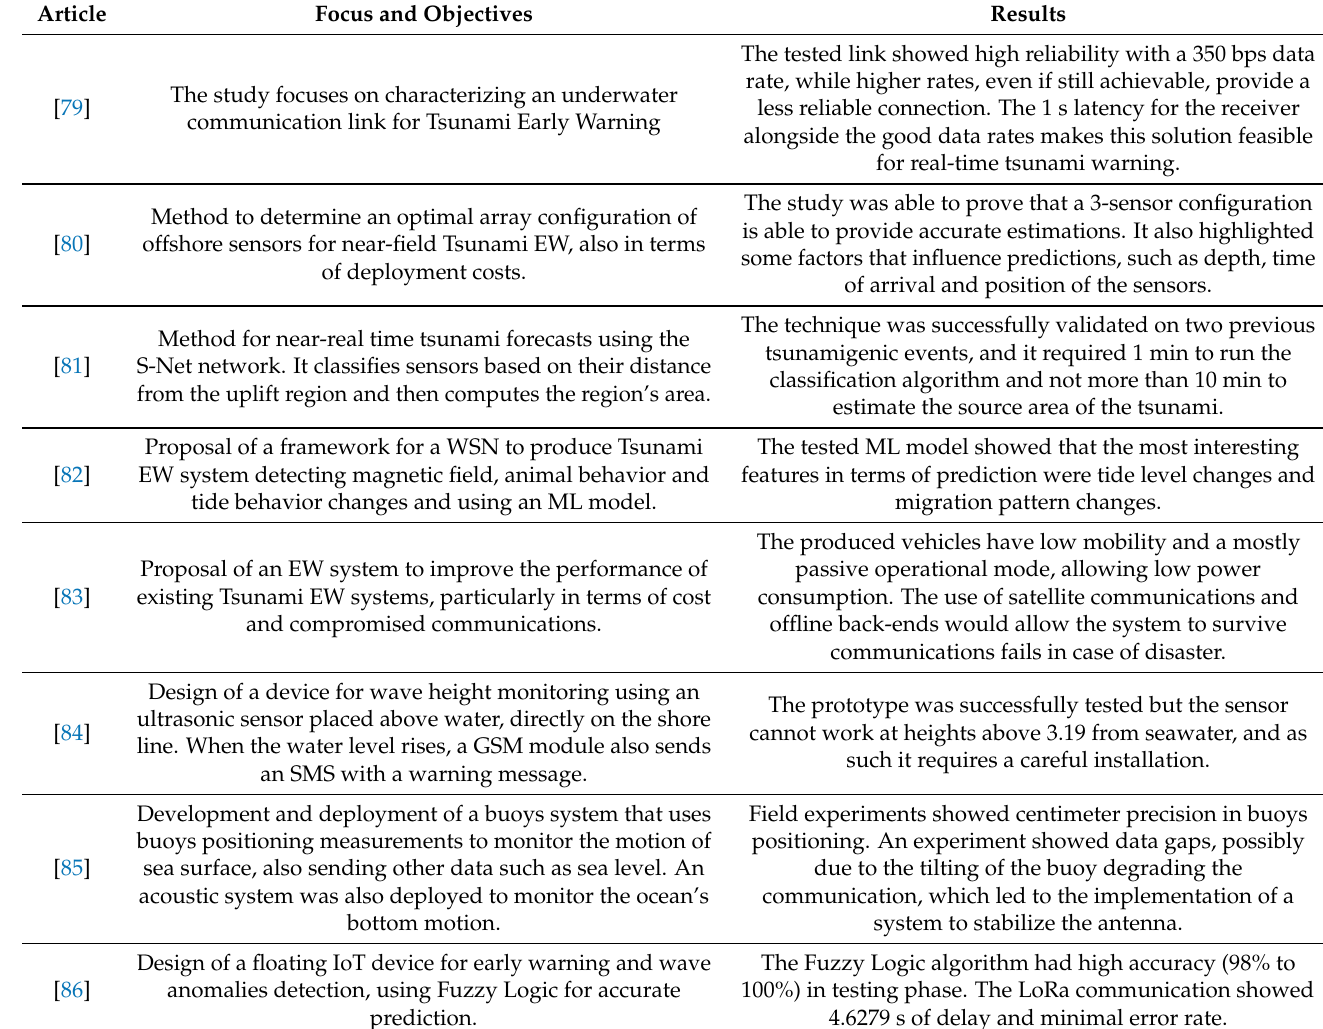
Table 5. Reviewed Articles in Tsunami